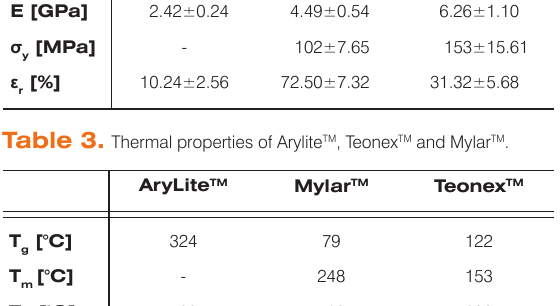
Figure 3. Stress-Strain curves of polyester substrates.